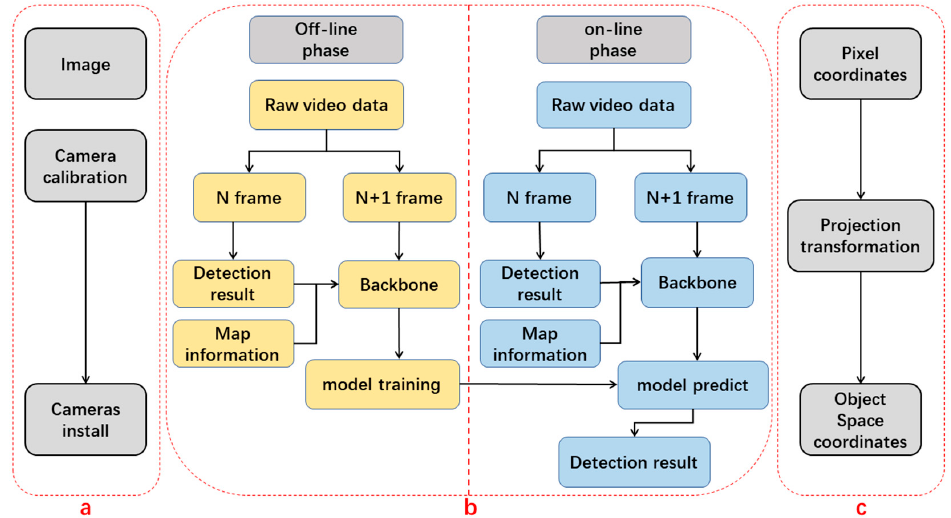
Figure 1. Overview of our passive visual positioning method. The process is composed of ( a ) pre- treatment; ( b ) pedestrian detection; ( c ) position estimation. ( a ) pretreatment; ( b ) pedestrian detection; ( c ) position